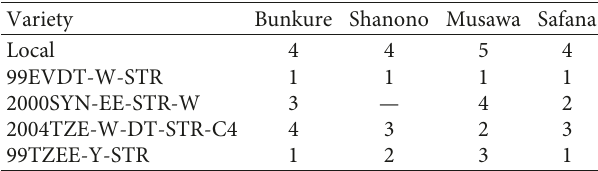
Table 4: Maize variety ranking using pairwise ranking (1 �